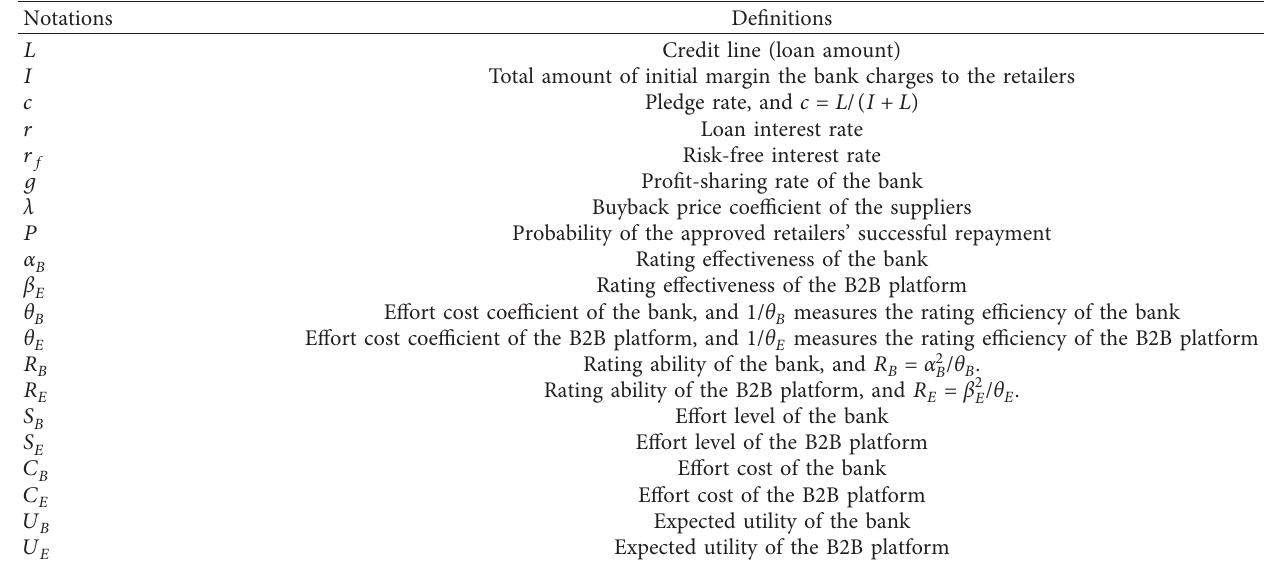
Table 1: Main notations and